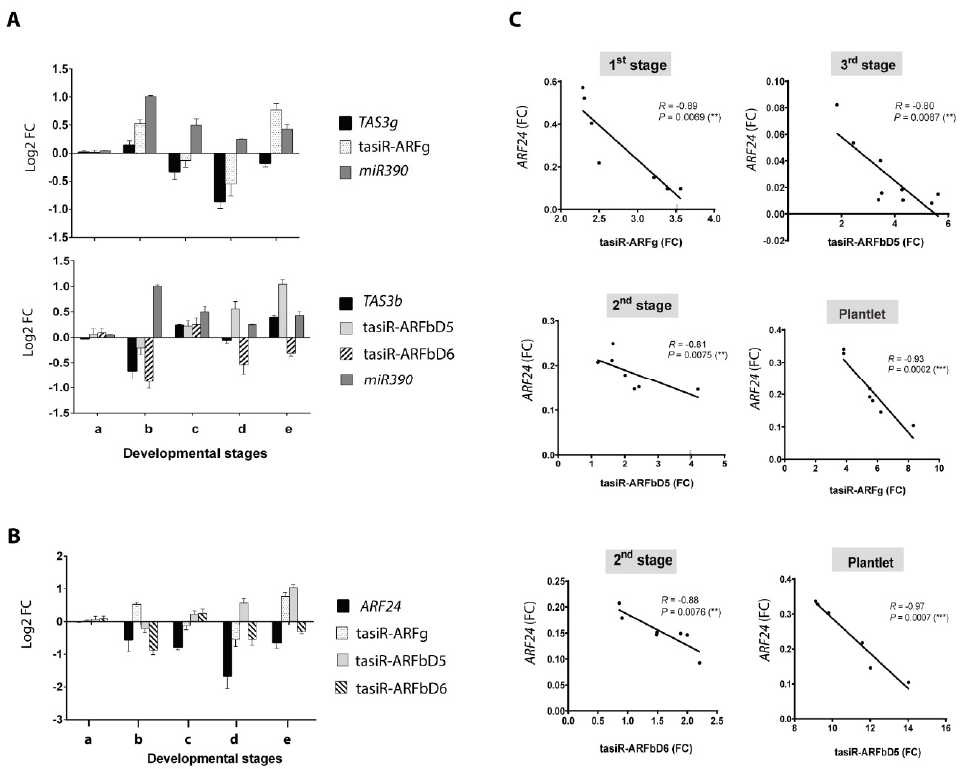
Figure 3. Correlation between accumulation patterns of precursors, tasiR-ARFs and the ZmARF24 target. ( A ) inverse correlation (IC) between TAS3 transcripts, tasiR-ARFs and miR390 levels. TAS3g shows IC with miR390 abundance, and tasiR-ARFg increment in the plantlet. Similarly, TAS3b inversely mirror a boost of tasiR-ARFbD5 levels at the 3rd stage and plantlet. ( B ) IC between tasiR-ARFs and ZmARF24 . ZmARF24 levels inversely correlate with distinct tasiR-ARFs depending on the developmental stage: (a) EC, (b) 1st stage, (c) 2nd stage, (d) 3rd stage and (e) plantlet. ( C ) the negative correlation between ZmARF24 and particular tasiR-ARFs was validated by Pearson’s correlation coefficients at different regeneration stages. Pearson analysis was performed using the FC values. FC was calculated using the 2 − ∆∆ ct method, considering EC tissue as reference and rRNA 18s or U6 snRNA as internal housekeeping controls. The R and p value are indicated on each